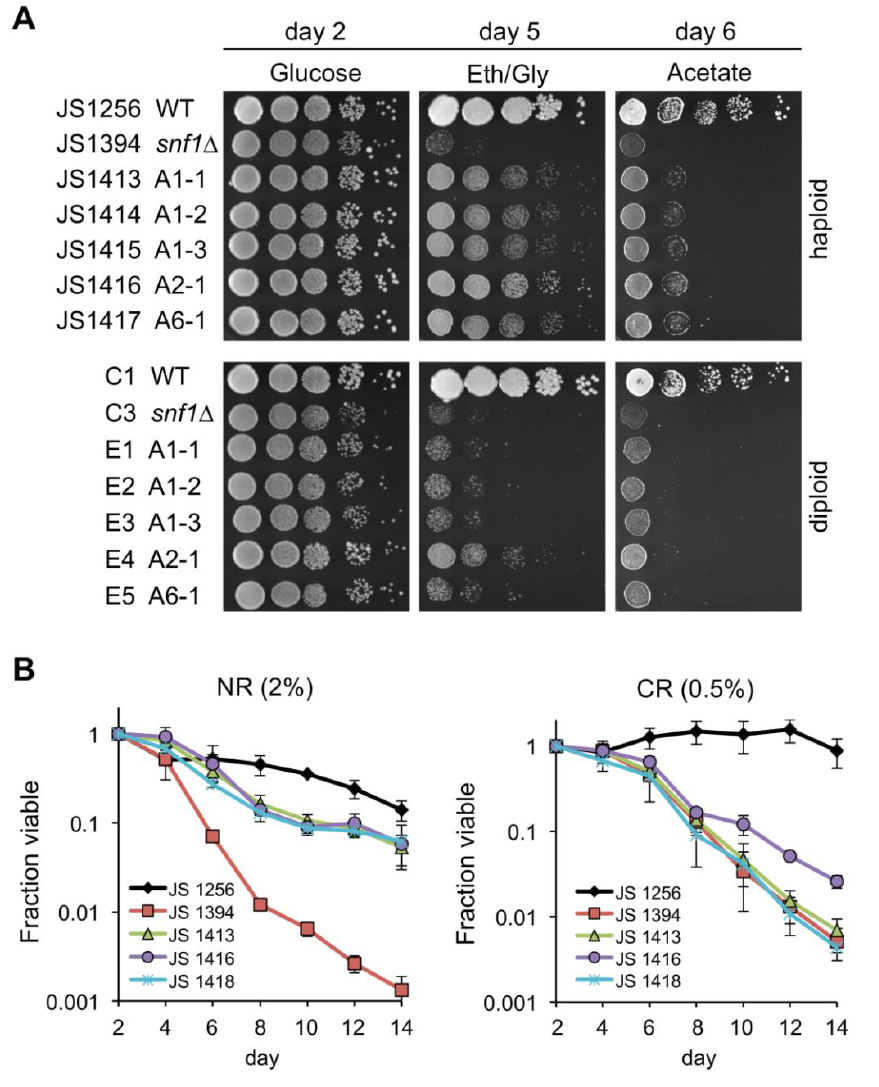
FIGURE 2: Characterization